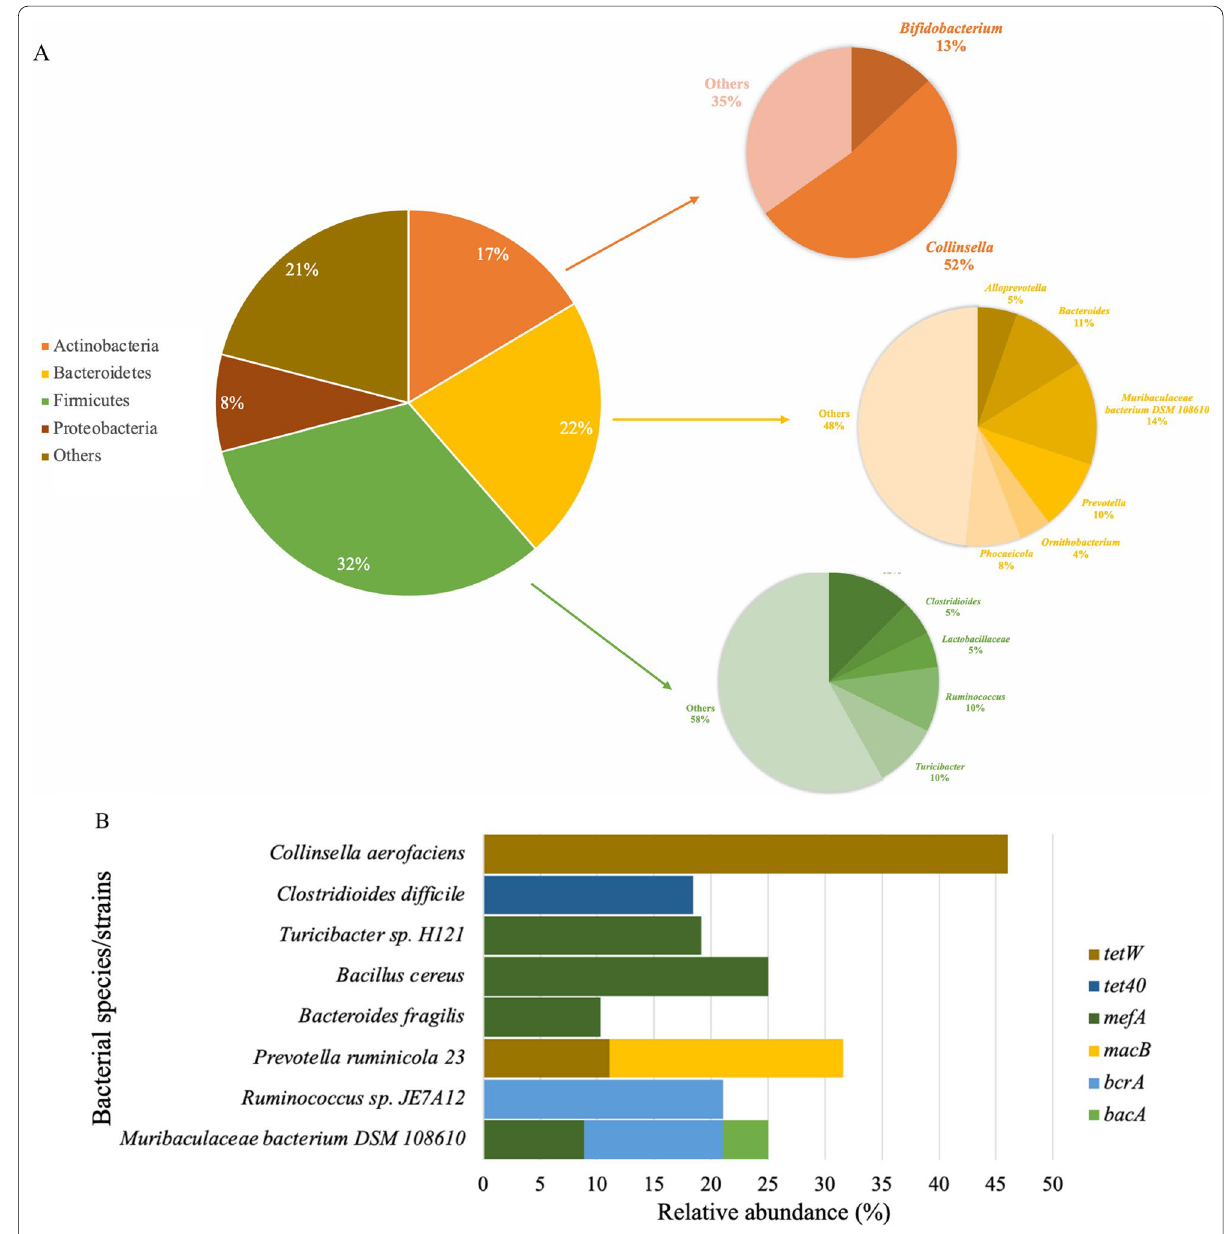
Fig. 5 The bacterial origin of active resistome. a Proportion of predicted bacterial hosts of expressed ARGs at phylum level. b Predicted bacterial hosts of 6 expressed ARGs including tetW , tet40 , mefA , macB , bcrA , and bacA and their relative abundance. ARG, antimicrobial resistant